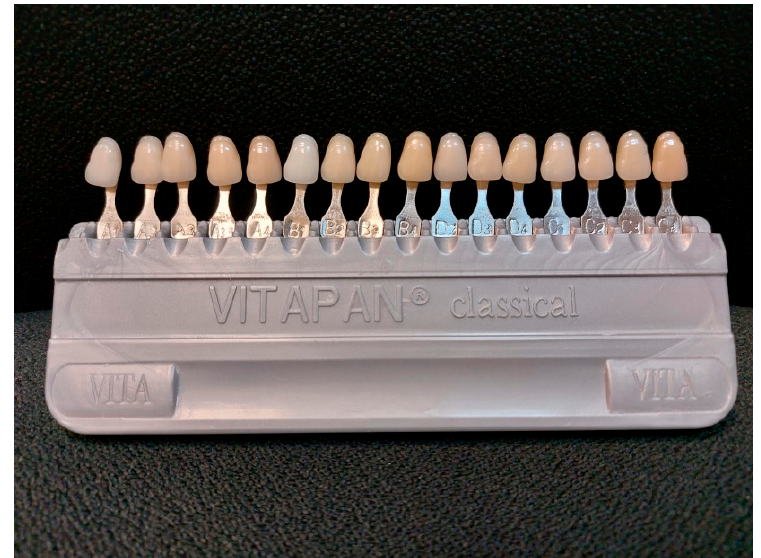
Figure 3. Vita Classical Shade Guide.